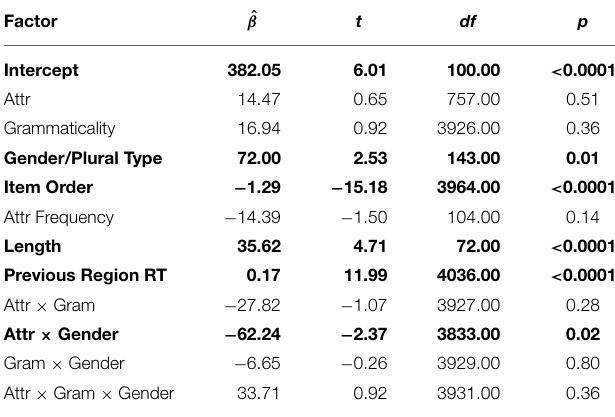
p-values computed using the Welch-Satterthwaite approximation. Predictors significantly different from 0 at α 0.05 highlighted in bold. =